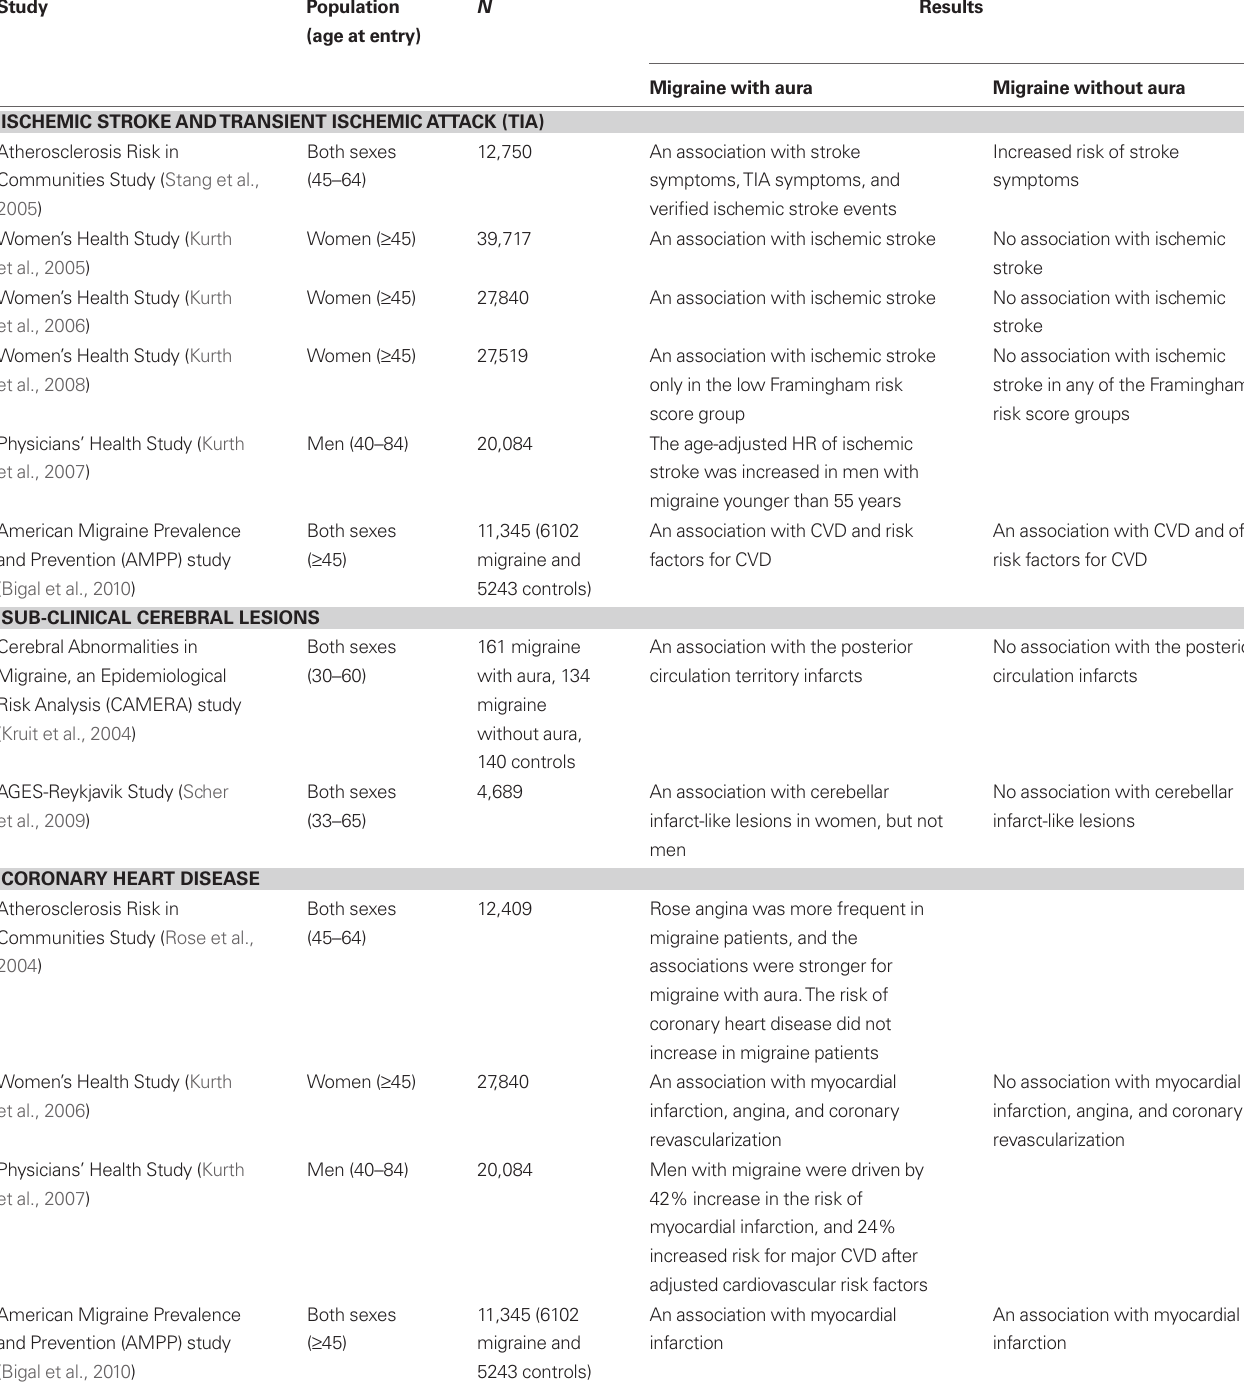
Table 1 | Summary of the studies of cardiovascular disorders (CVD) and